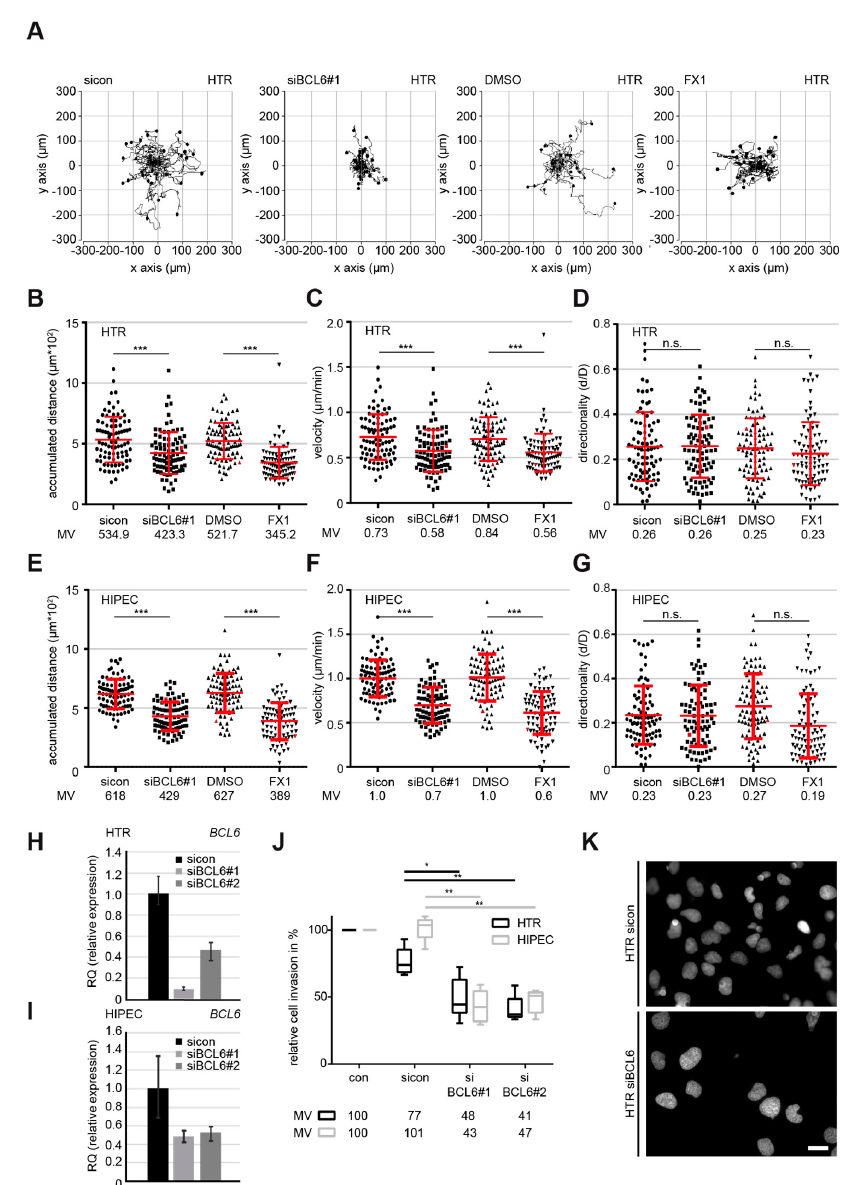
Figure 2. Inhibition of BCL6 reduces the motility of first trimester trophoblastic cells. ( A – D ) Time-lapse microscopy was performed with HTR cells, depleted of BCL6 with siBCL6#1 or treated with the BCL6 inhibitor FX1 for up to 12 h. The random motility of these cells was analyzed. Representative trajectories of individual cells ( n = 30) are shown ( A ). The evaluated accumulated distance ( B ), velocity ( C ), and directionality ( D ) from three independent experiments are presented as scatter plots with variations. *** p < 0.001, * p < 0.05 and, n.s. p > 0.05. ( E – G ) Time-lapse microscopy was performed with HIPEC cells, depleted of BCL6 with siBCL6#1 or treated with the BCL6 inhibitor FX1 for up to 12 h. The random motility of these cells was analyzed. The evaluated accumulated distance ( E ), velocity ( F ), and directionality ( G ) from three independent experiments are shown as scatter plots with variations. *** p < 0.001. ( H – K ) Invasion assay. HTR or HIPEC cells were treated with sicon or siBCL6#1, seeded into Transwell systems, and starved for 12 h. The cells were released into fresh medium for 24 h and fixed for quantification. The BCL6 gene levels were measured in HTR ( H ) or HIPEC cells ( I ) as transfection efficiency controls. Representatives of invaded HTR cells are shown ( K ). Scale: 25 µ m. Invaded cells were quantified. The total number of invaded cells in the control group was assigned as 100%. The results were obtained from three independent experiments and are presented as the mean ± SEM ( J ). ** p <